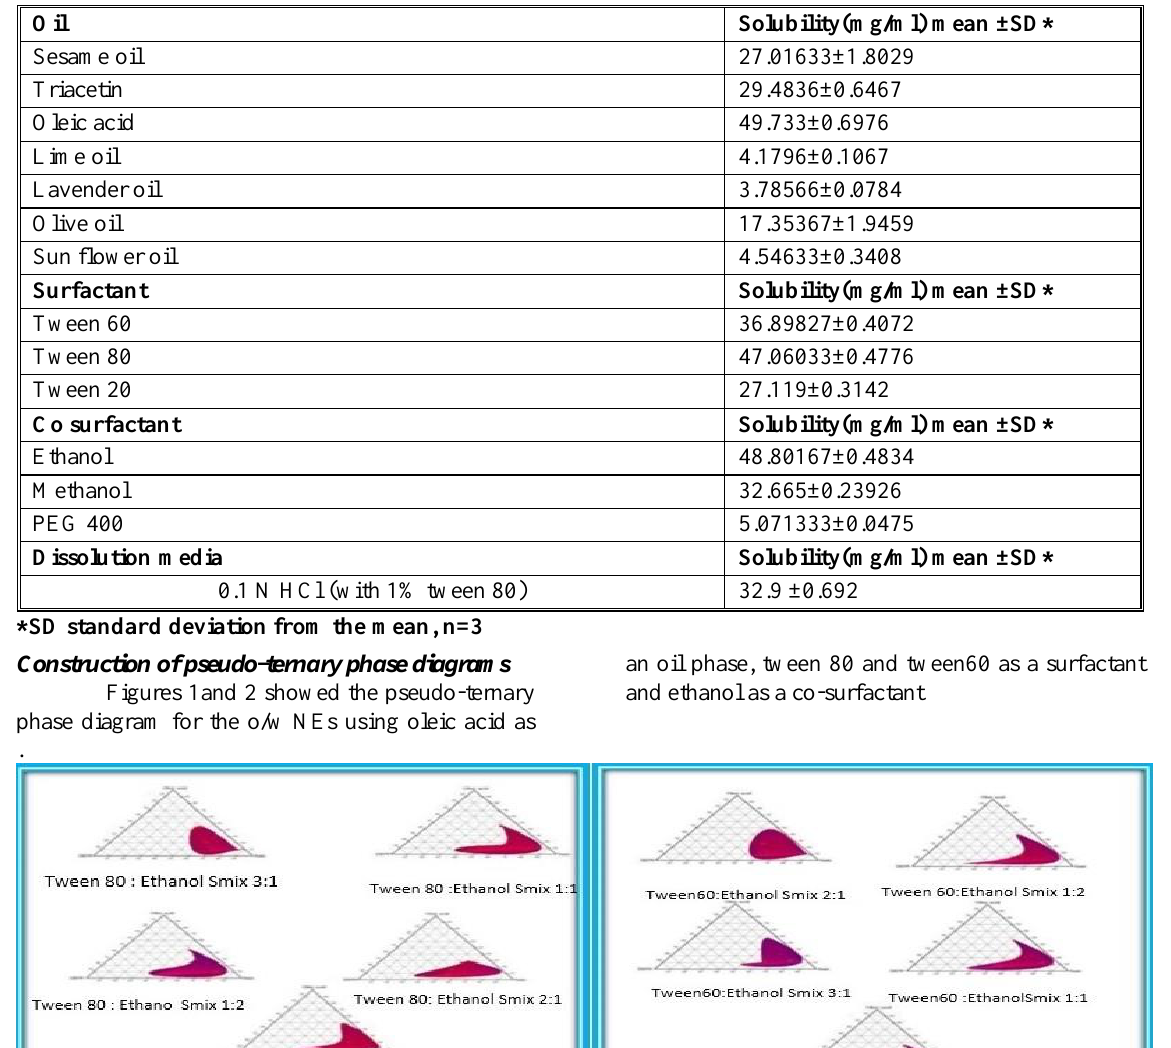
Table 3.Saturation solubility study of felodipine in different oils, surfactants, co- surfactants and dissolution